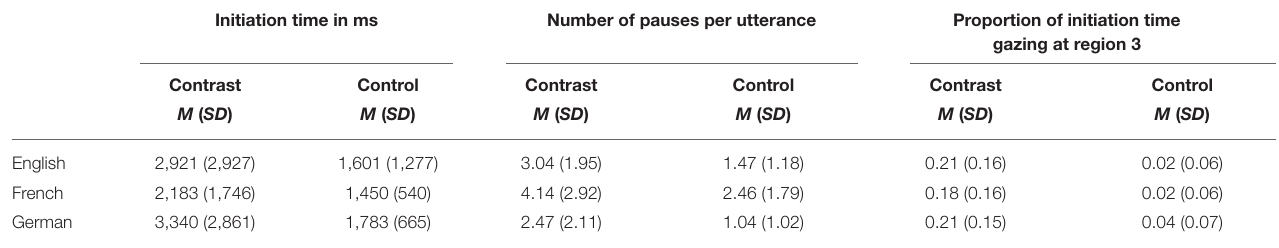
TABLE 2 | Descriptive statistics (means and standard deviations) for the three dependent variables, by language and display type (contrast vs.